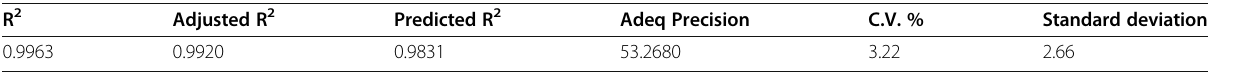
Table 6 Fit statistics of the response model for xylanase activity of Pseudomonas mohnii calculated by response surface methodology